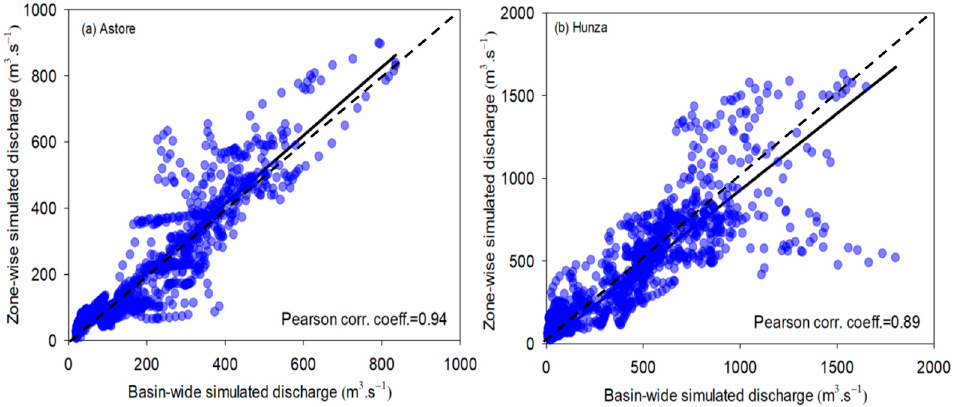
Figure 6. Evaluation of zone-wise (ZW) SRM application over 2000–2004 period for ( a ) Astore and ( b ) Hunza basins.